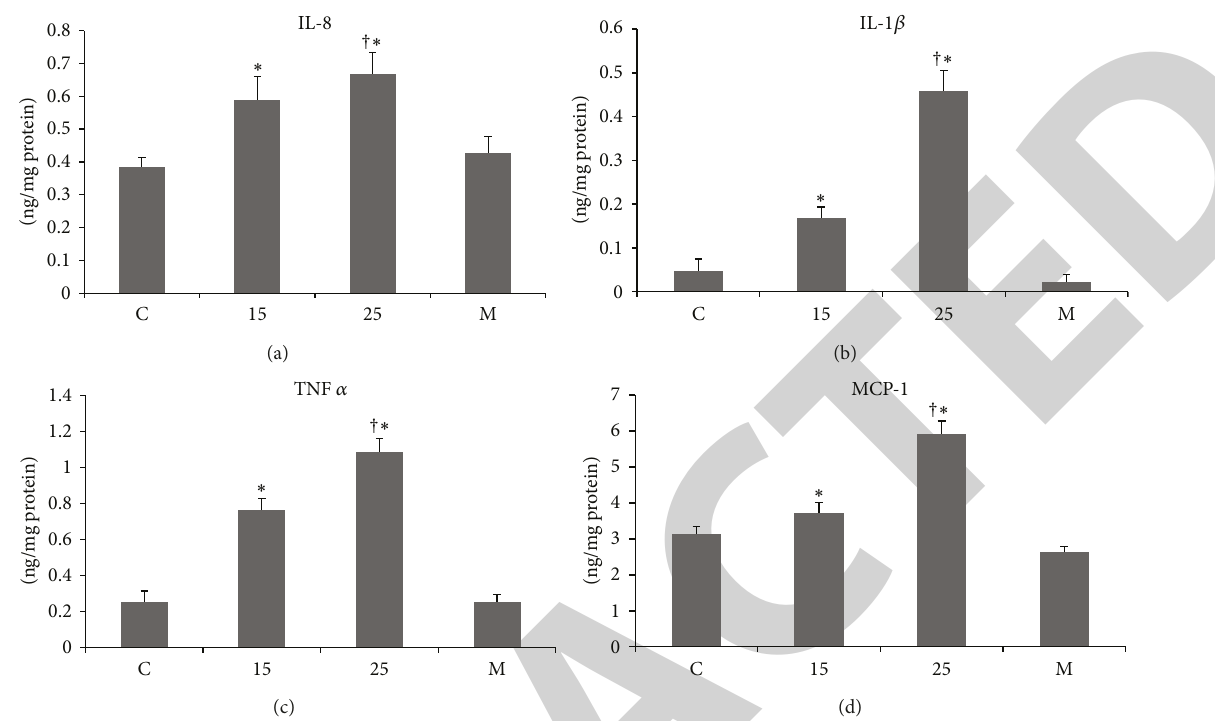
Figure 3: High glucose induces increased inflammatory biomediator release: HMVRECs were incubated and treated with 5.5, 15, and 25mM glucose and mannitol as described in Methods and legend of Figure 1. Thereafter cell supernatants were collected for ELISA. (a) IL-8, (b) IL-1 𝛽 , (c) TNF- 𝛼 , and (d) MCP-1 levels are increased under hyperglycemic conditions. ∗ 𝑃 < 0.001 versus controls and † 𝑃 < 0.001 versus